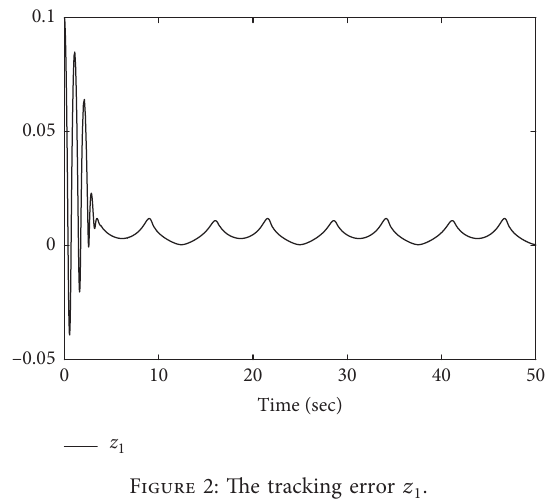
d and system output